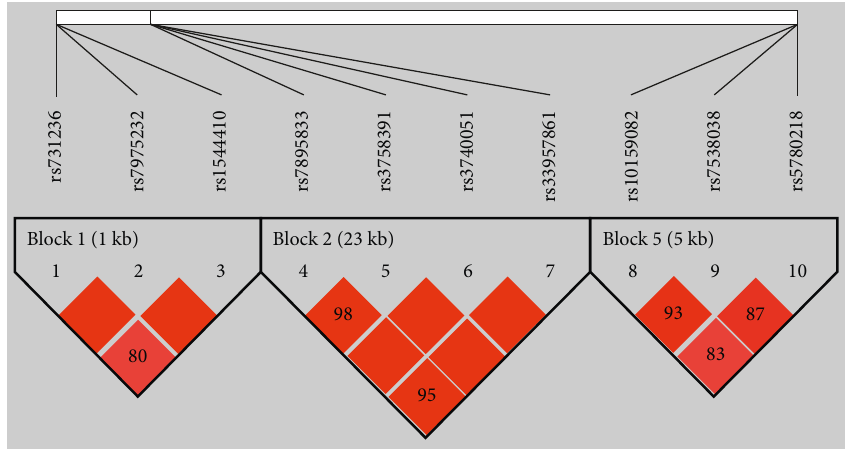
Figure 1: Linkage disequilibrium (LD) plot for VDR, SIRT1, and KISS1 genes. LD coefficient values (D’) corresponding to each SNP pair are expressed as a percentage and shown within the respective square. Three SNPs in VDR, four SNPs in SIRT1, and three SNPs in KISS1 comprised one block (Block 1, Block 2, and Block 3, respectively). Table 4: Haplotype analysis in the study population.